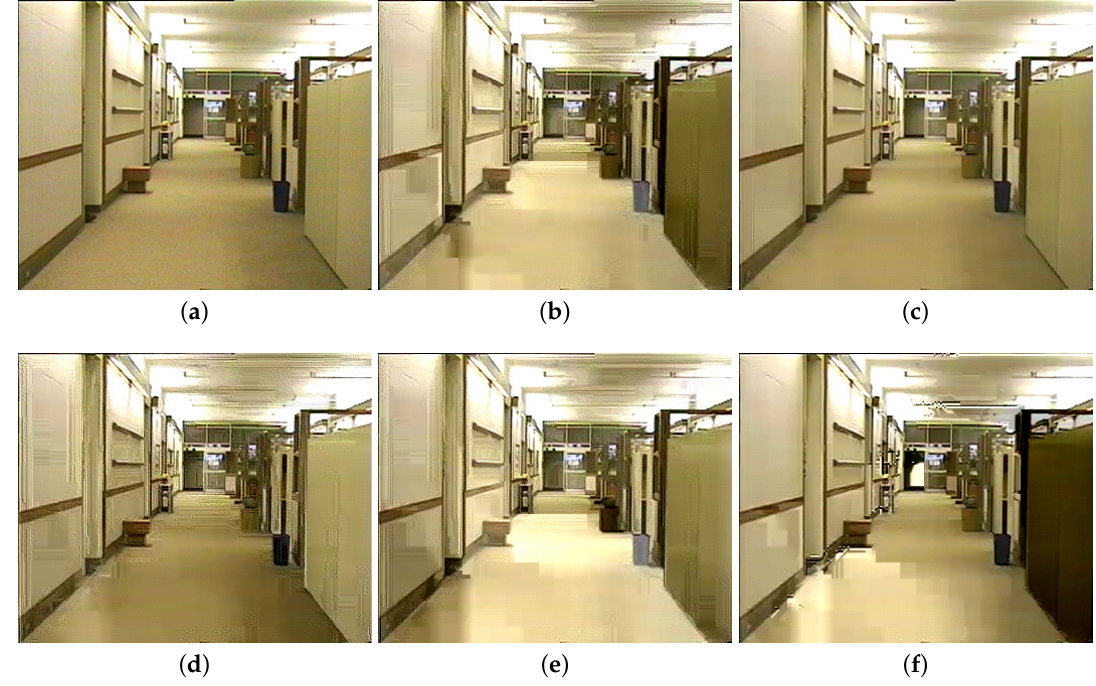
Figure 3. Tenth frame of the Hall monitor video sequence encoded with QP = 30 after data hiding up to full payload. ( a ) The original video; ( b ) The proposed stego video; ( c ) The stego video of [13]; ( d ) The stego video of [12]; ( e ) The stego video of [11]; ( f ) The stego video of